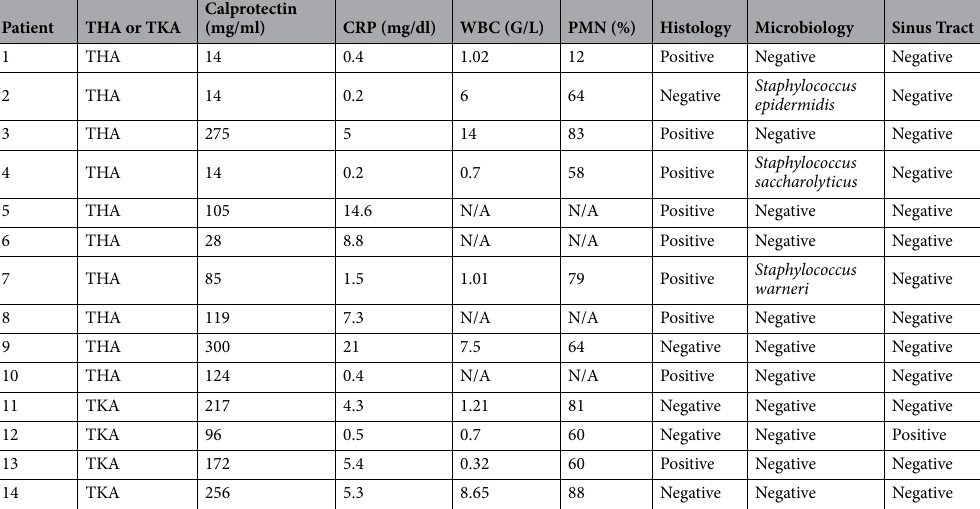
Table 3. Results of calprotectin, serum CRP, synovial WBC, synovial PMN, histology, microbiology and clinical findings of the confirmed infections according to the modified EBJIS 2021 definition of PJI.